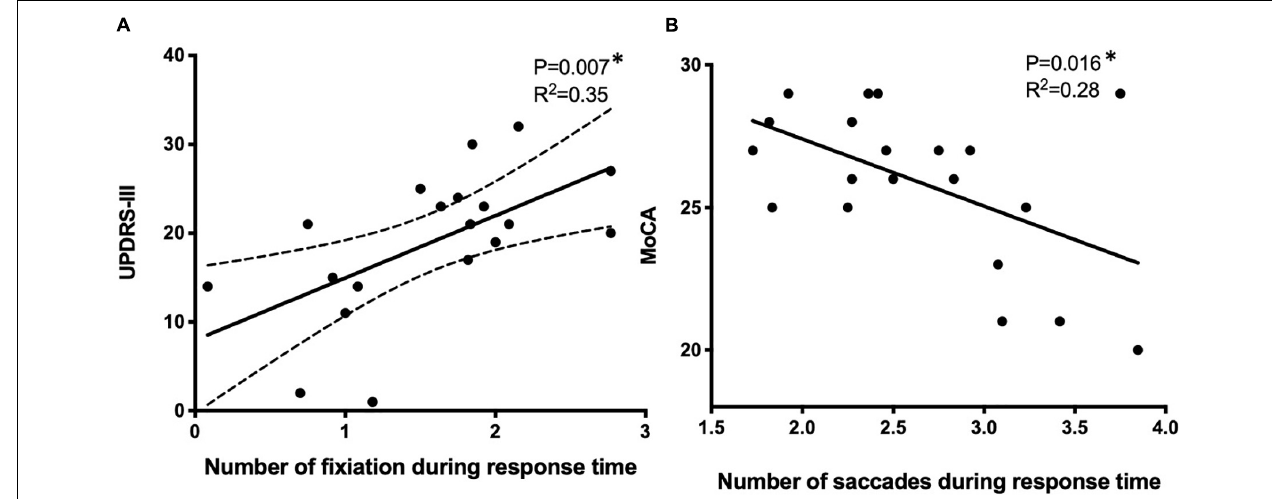
FIGURE 5 | The correlation of eye motion trajectory with disease status using the univariate linear regression model. Eye motion trajectory data were analyzed against UPDRS-III (A) and MoCA (B) . ∗ p < 0.05, using univariate regression models. UPDRS-III, Unified Parkinson’s Disease Rating Scale, MoCA, Montreal Cognitive